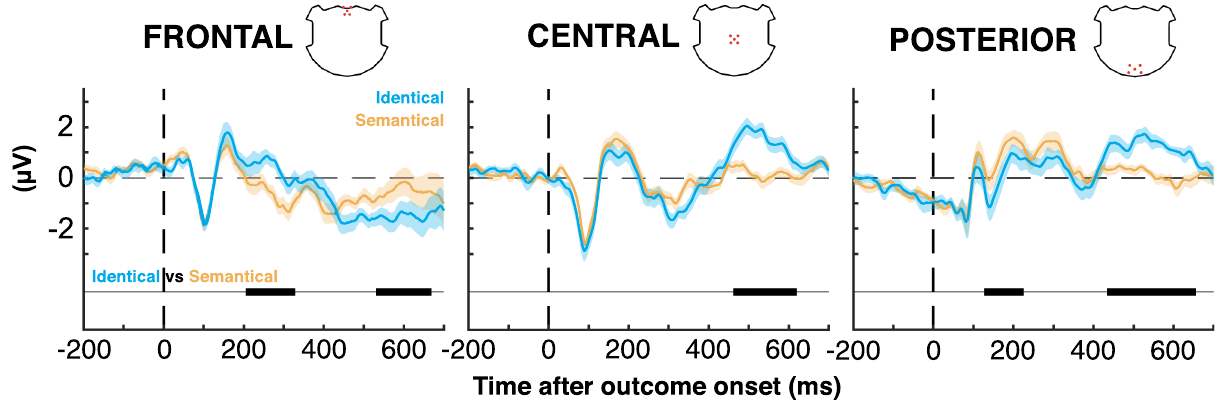
Figure 4. Cluster waveform comparison between outcomes SIMI of identical (bleu) and semantical (orange) conditions, at the three clusters: frontal (left), central (middle), posterior